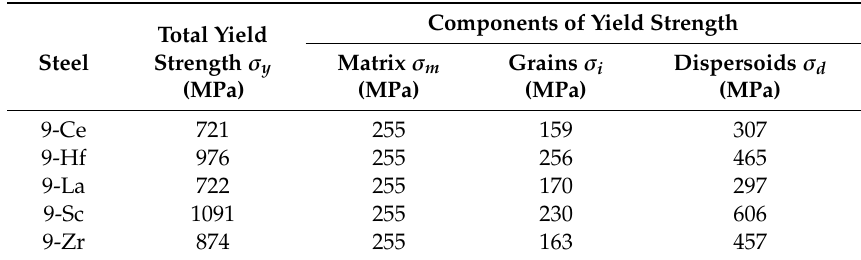
Table 5. Calculated yield strength of the prepared steels and their components.